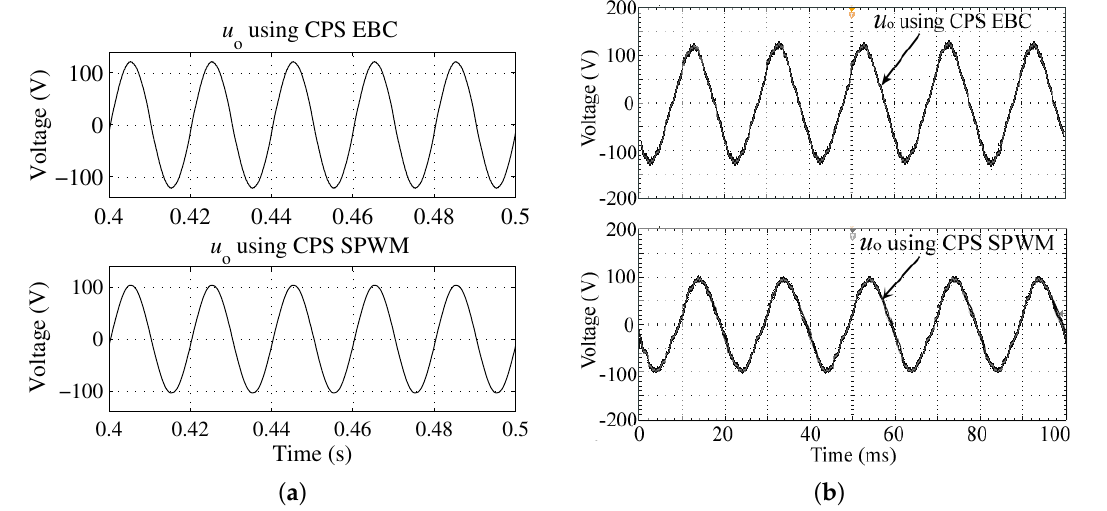
Figure 11. The results of the five-level prototype under the case of power imbalance ( u 1 = 65 V and u 2 = 80 V). ( a ) Simulation results; and ( b ) Experimental